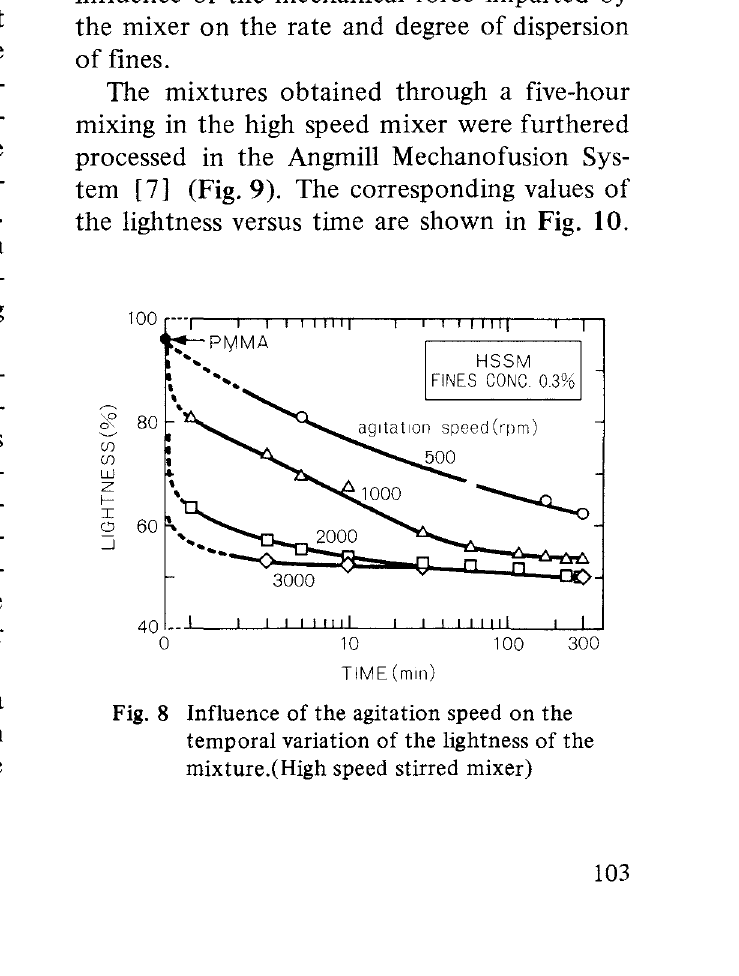
Fig. 8 Influence of the agitation speed on the temporal variation of the lightness of the mixture.(High speed stirred mixer)